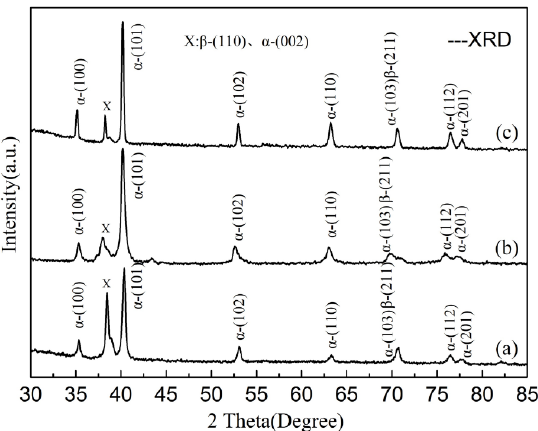
Figure 4. XRD patterns of the TA19 titanium alloy: ( a ) initial microstructure, ( b ) EM, and ( c ) S-EM.